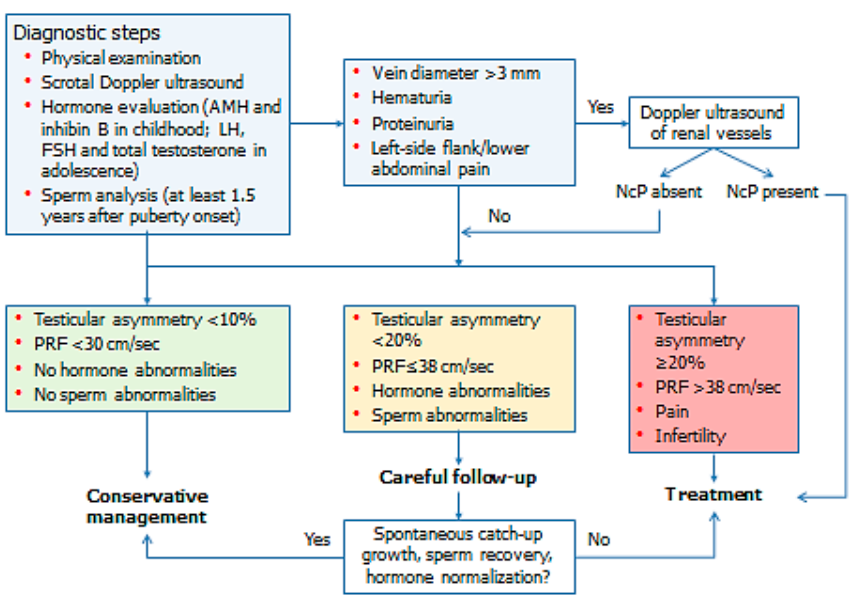
Figure 1. Management of childhood and adolescent varicocele.